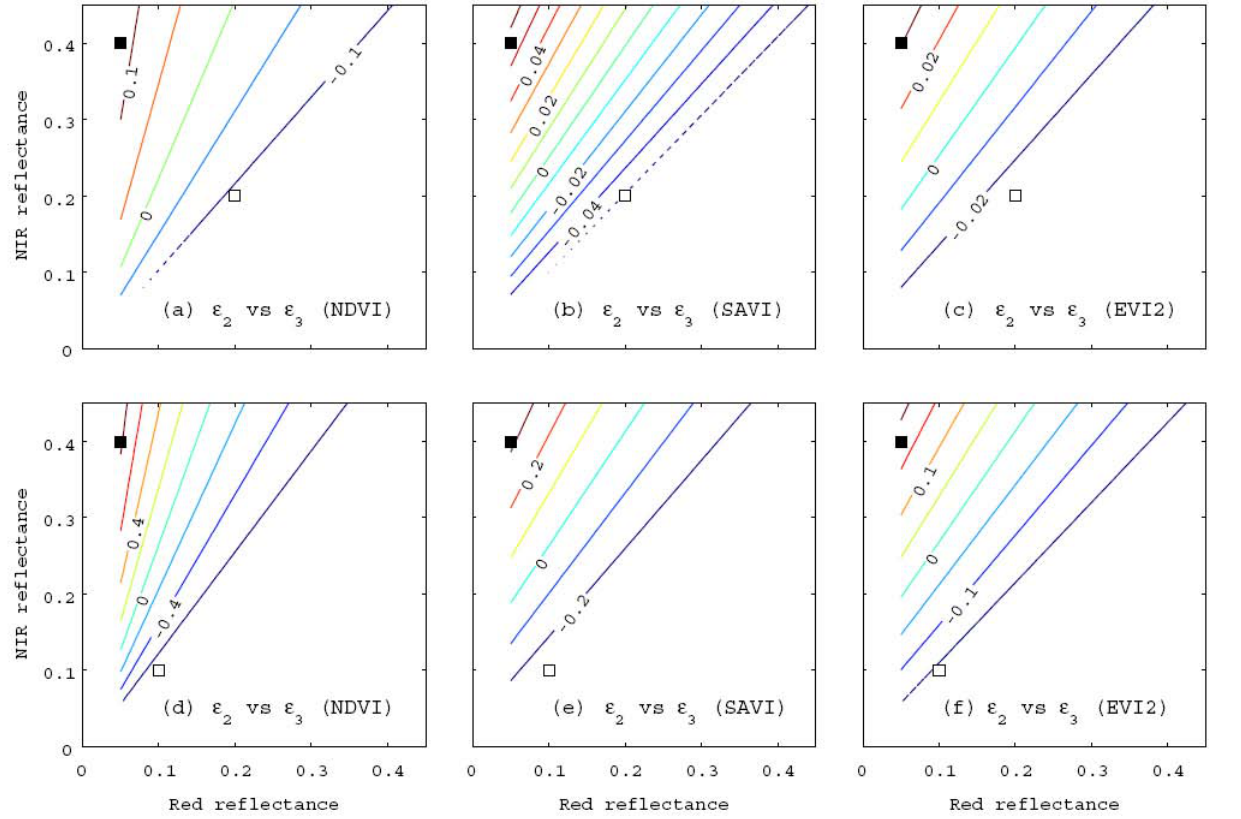
Figure 12. Results of numerical simulations describing a distribution of α on a log scale over the red-NIR reflectance spectrum to compare algorithm-2 and -3 using identical VI conditions (comparison of the inter-algorithm relationship). The results indicate the influence of the target spectrum, endmember spectra, and choice of VI on tan θ show the tan θ -map using NDVI and SAVI, NDVI and EVI2, and SAVI and EVI2 as the 0 conditions for algorithm-2 and -3 based on EM1. ( d – f ) show the tan θ assumed in the upper three panels, based on